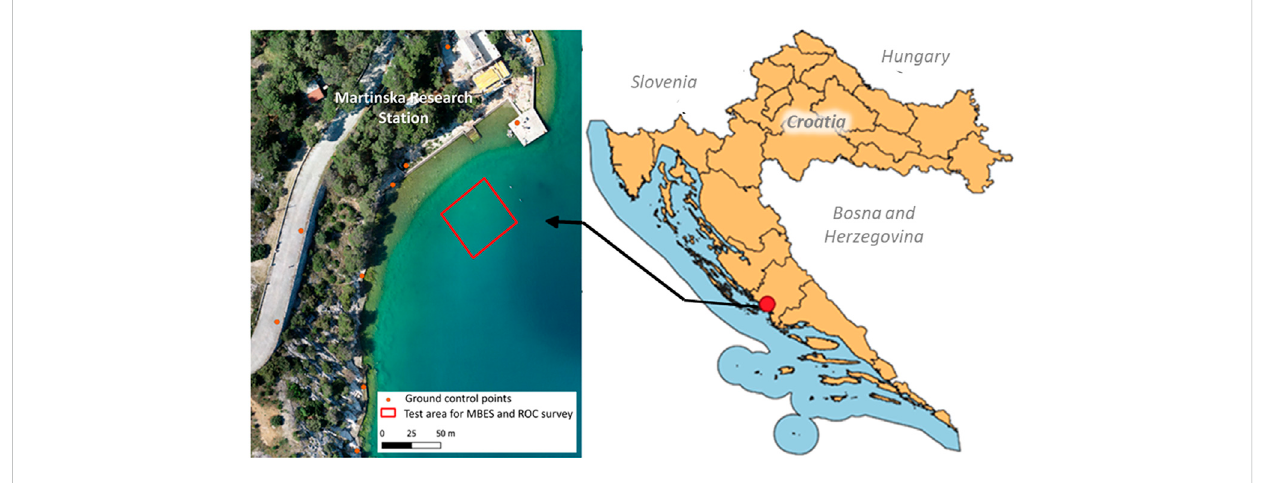
FIGURE 1 Location of the study area near Martinska research